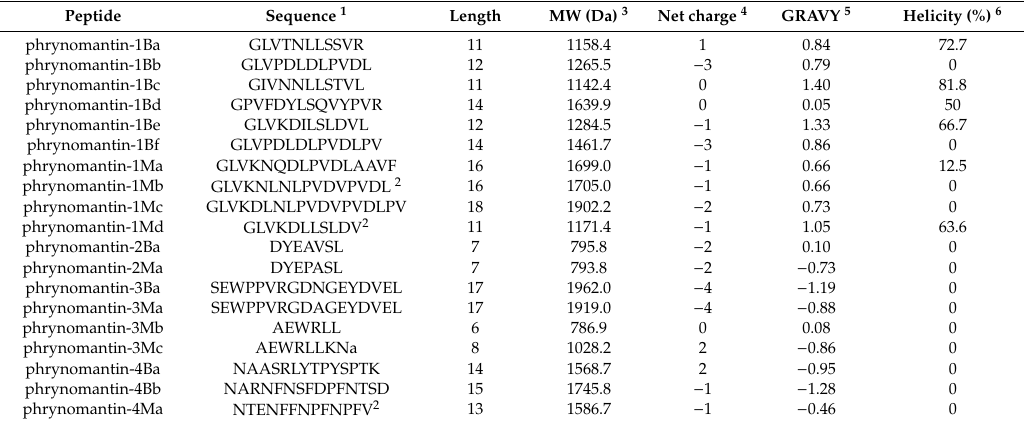
Table 2. Physicochemical and structural properties of the predicted phrynomantins.